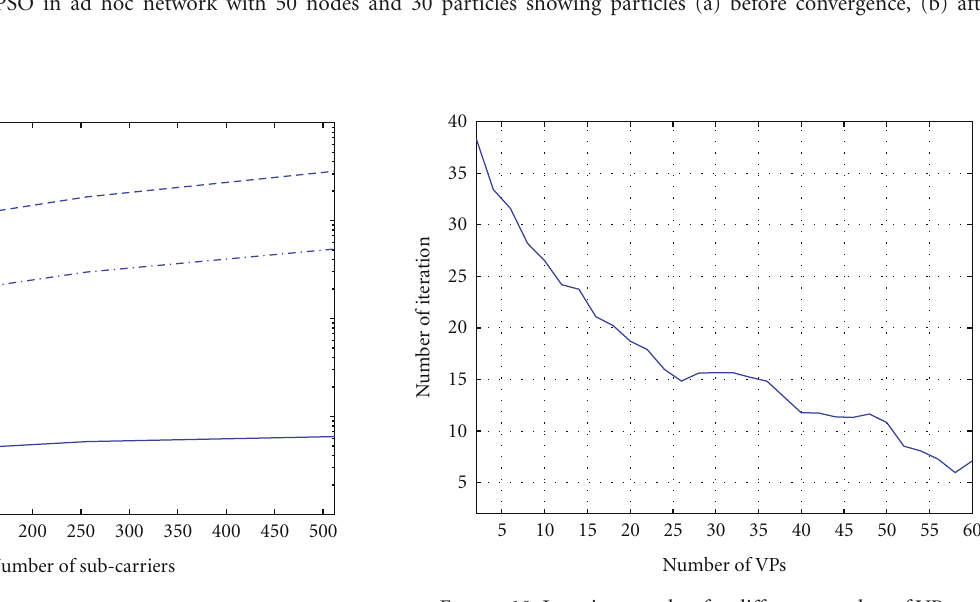
the algorithm. Computational complexity of the distributed PSO on a single node is in order of O ( g ( Γ )) where g ( Γ ) is the complexity function for Γ iterations on each node and is defined according to algorithm implementation. The complexity will increase to O ( Qg ( Γ )) when Q number of particles ( Q < P ) overlap on the node. In TPSO, when there is more than one particle over a node, they are collectively considered as one super particle. Each super particle is treated in a similar way to normal particles, and hence using super particles reduces the number of required packets. Since Q and Γ are reduced as a result of batching the particles with an identical destination to a super particle, the algorithm complexity will